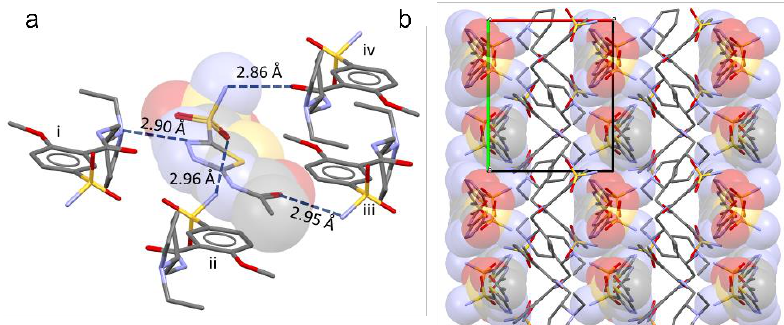
Figure 7. ( a ) Intermolecular interactions established between AZA anion and surrounding hydro- genated SULP molecules (dashed blue lines). ESDs are omitted for the sake of clarity. ( b ) Crystal packing of SULP-AZA along (001) direction. Color code C = grey, N = blue, O = red, S = yellow. AZA anions are highlighted with spacefill style shadow. Hydrogen atoms are omitted for the sake of clarity.